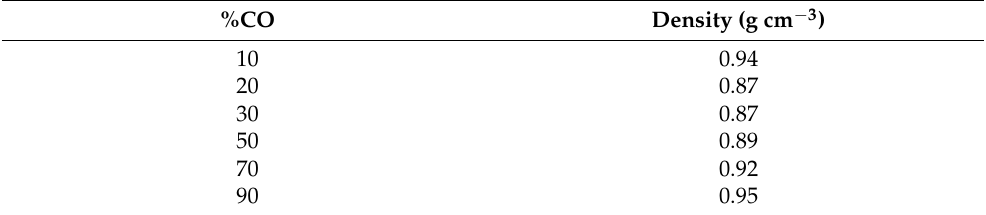
Table 3. Density of CO in N 2 mixtures as determined by the molar ratio of CO within the mixture at a constant temperature of 14 K. Experimental values from Satorre et al. [44].